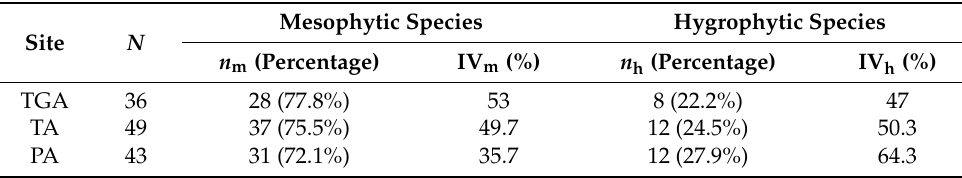
Table 1. Proportions of mesophytic and hygrophytic plant species at three sites subject to different levels of disturbance in the KGTA and YWNR, Beijing Municipality, China.